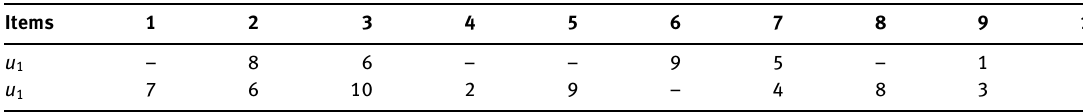
Table 1: Example of Partial Ranking